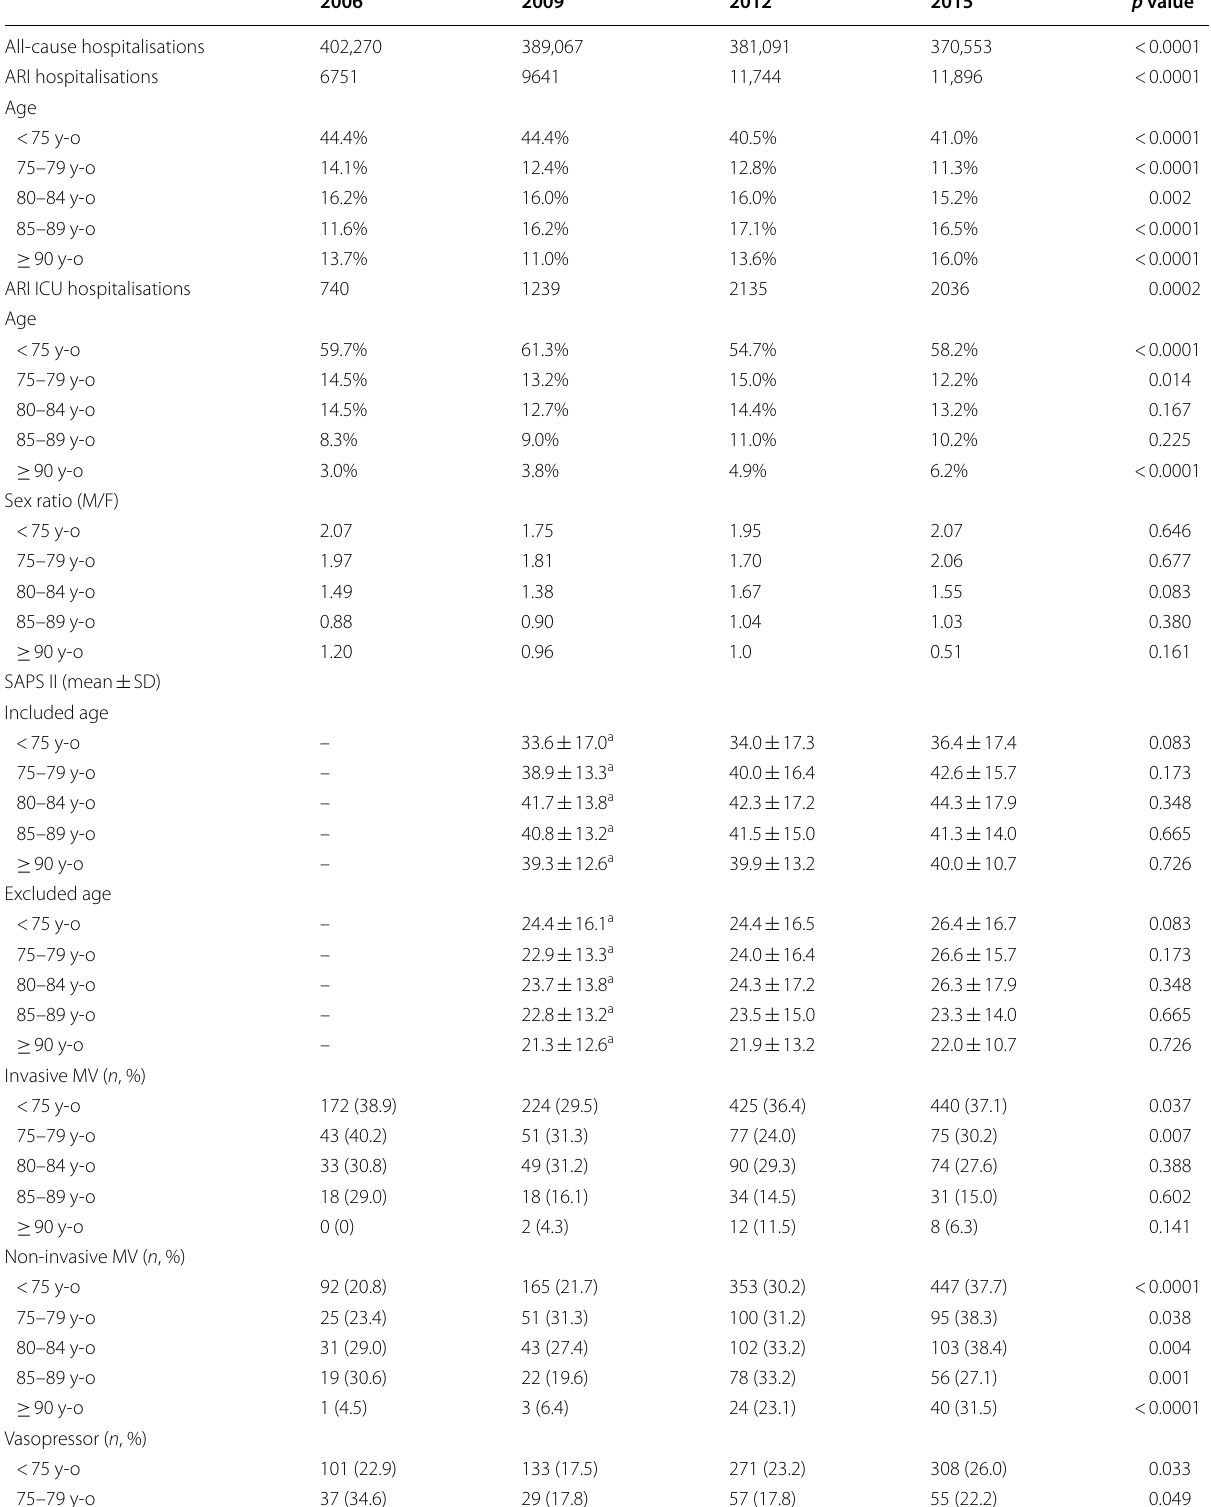
Table 1 Characteristics of hospitalisations for ARI in 2006 and